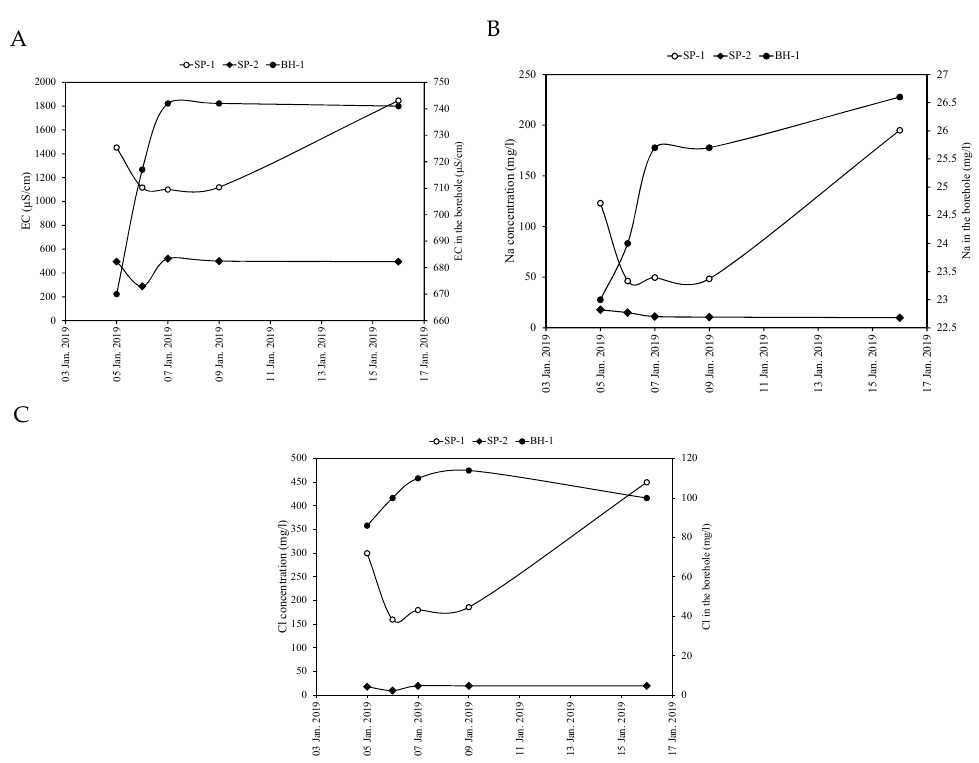
Figure 8. Results of the groundwater samples taken from the BH-1 borehole, SP-1, and SP-2 springs during winter 2019. Snow events were on 3 and 4 January 2019 (see Figure 7D): ( A ) the groundwater samples’ EC changes; ( B ) the groundwater samples’ Na + changes; ( C ) the groundwater samples’ Cl - changes.